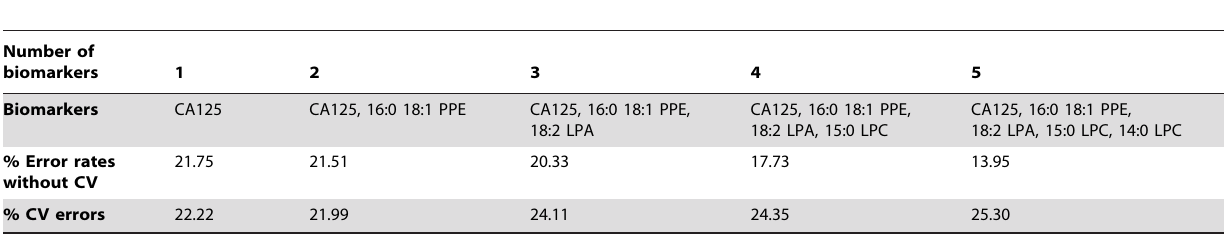
Table 3. Estimated error rates for the support vector machine models for classifying benigns and cases.